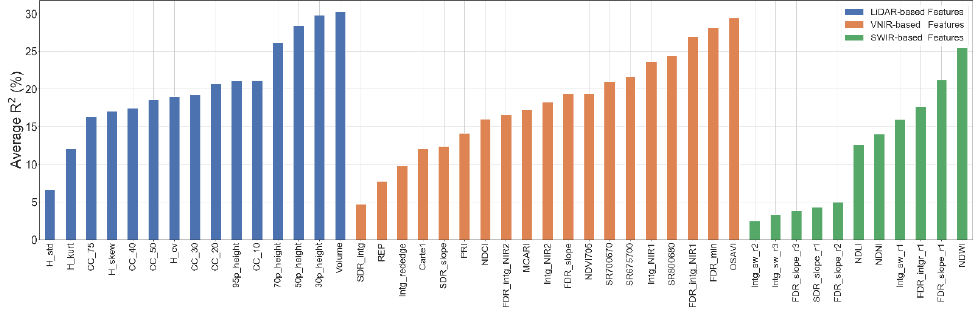
Figure 15. R 2 values of the linear regression-based models developed for the end of season fresh biomass using visible and near infrared (VNIR) features at four stages of growth. Feature 1 to 8 represent: #1: FDR_min, #2: Intg_NIR1, #3: SDR_slope, #4: Intg_NIR1, #5: NDVI, #6: SR 800,680 , #7: OSAVI, and #8: MCARI.